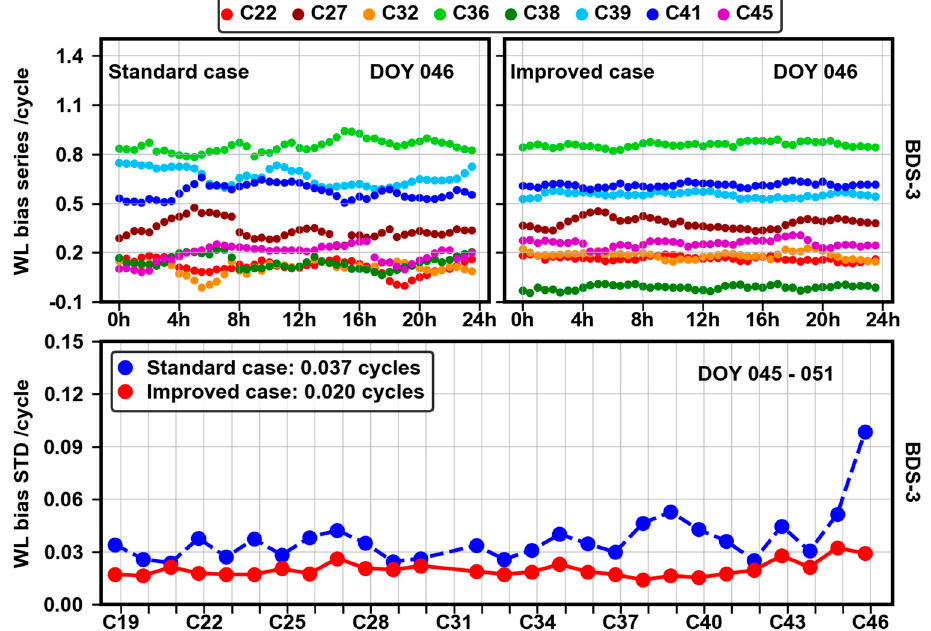
Figure 13. WL phase bias series on DOY 46, 2021 and the corresponding STDs across 7 days for BDS‐3 for the standard case and improved case for the Case 4 network.